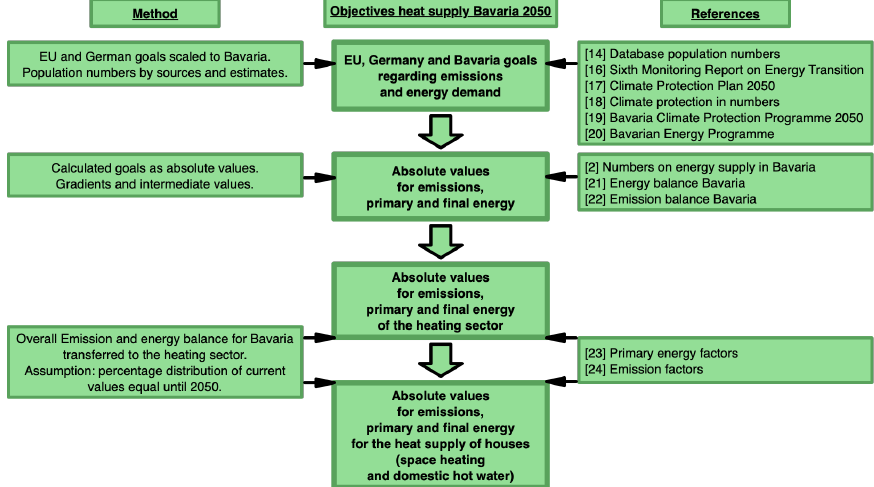
Figure 4. Objectives for the heat supply of residential buildings in Bavaria until 2050. ([14, 16–20], [2, 21, 22], [23, 24]).